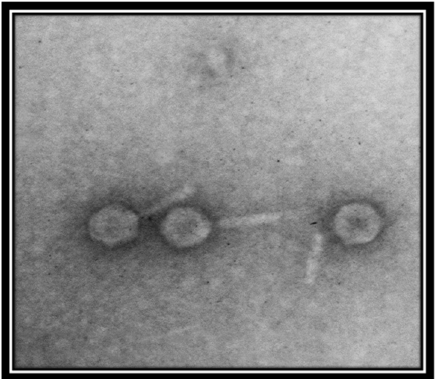
Figure 2. Transmission electron micrograph of Salmonella -phage-SSBI34. The phage was stained with 1% uranyl acetate solution. Images were taken at an acceleration voltage of 80 kV. The scale bar represents 100